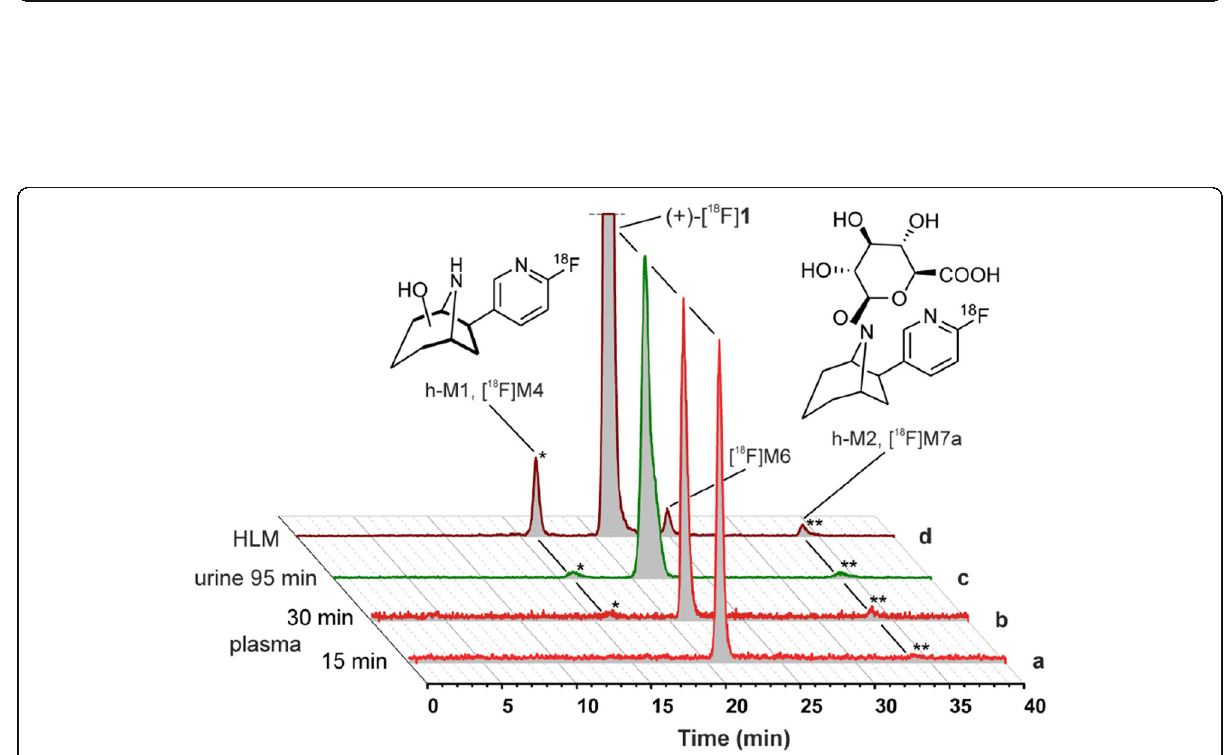
Fig. 9 Comparison of metabolic profiles of (+)-[ 18 F]1 (in vivo vs. in vitro) and identification of radiometabolites. Representative radio-HPLC chromatograms of samples obtained from human subjects: (a) plasma, 15 min; (b) plasma, 30 min; (c) urine, 95 min after injection; and (d) after HLM incubation (NADPH, UDPGA, TRIS, pH 8.4, 37 C, 120 min). Scaling was adjusted for each chromatogram. Adapted with permission from Ref. [71]